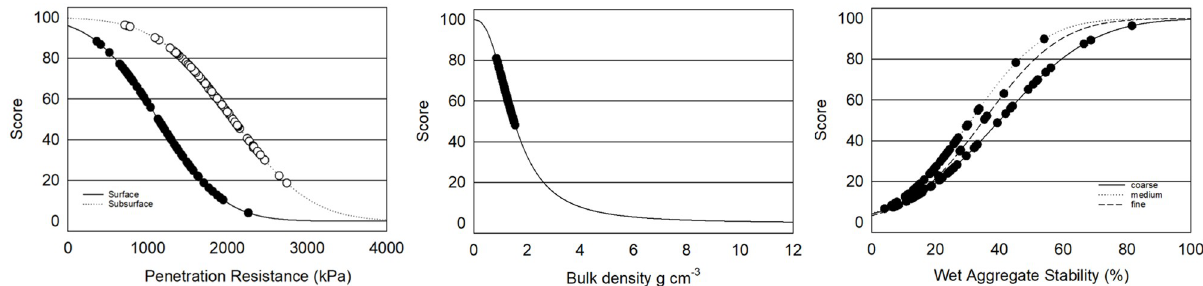
Fig 5. Indicators of soil structure: Penetration resistance, bulk density, and wet aggregate stability in 101 Central Washington orchards field soils.